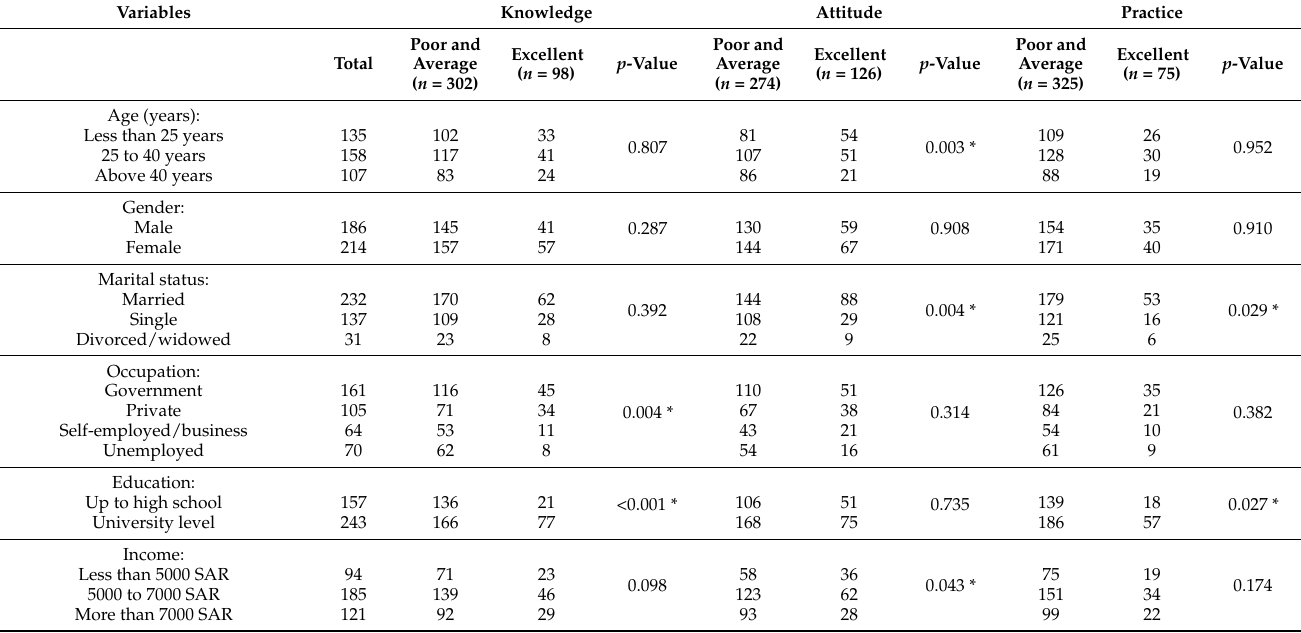
Table 2. Relationship between each sociodemographic characteristic and each KAP category ( n = 400).